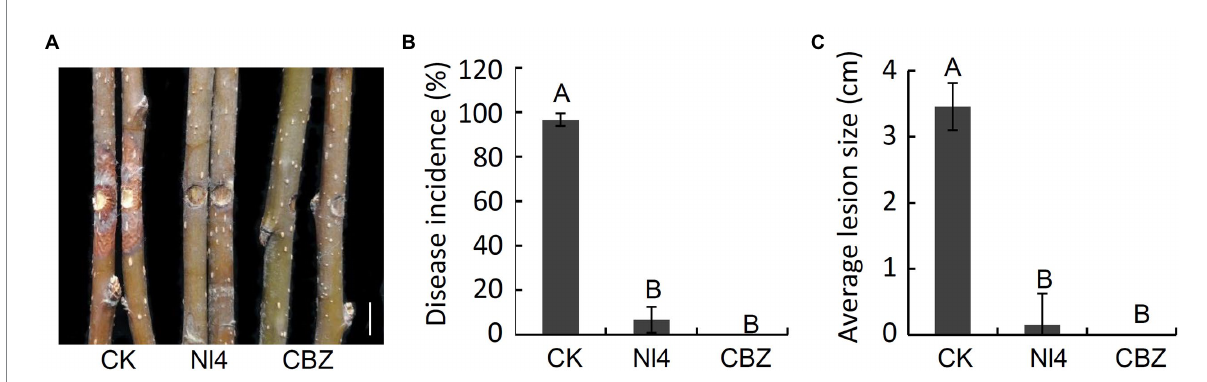
FIGURE 6 Biocontrol activity of P. polymyxa strain Nl4 in controlling pear Valsa canker caused by V. pyri . (A) Suppression of strain Nl4 cell suspension on pear Valsa canker. Sterile distilled water or carbendazim (CBZ) treatment was used as the negative and positive control, respectively. Bar = 1 cm. (B) Statistical analysis of the disease incidence. (C) Statistical analysis of disease lesion size. Each data represents the mean ± SD of three replicates. Disease lesion size and disease incidence were measured at 7 dpi. Letters above the bars indicate statistical significance and different uppercase letters indicate significant different means ( p < 0.01) based on Student’s t-test.